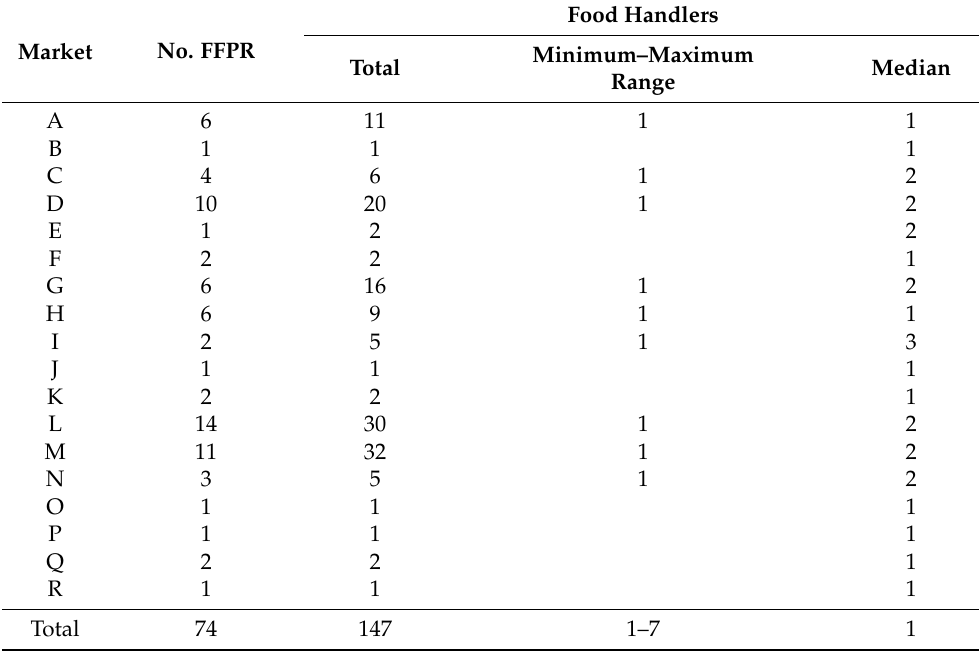
Table 1. Food handler distribution in fresh fishery product retailers of Lisbon´s traditional food markets.